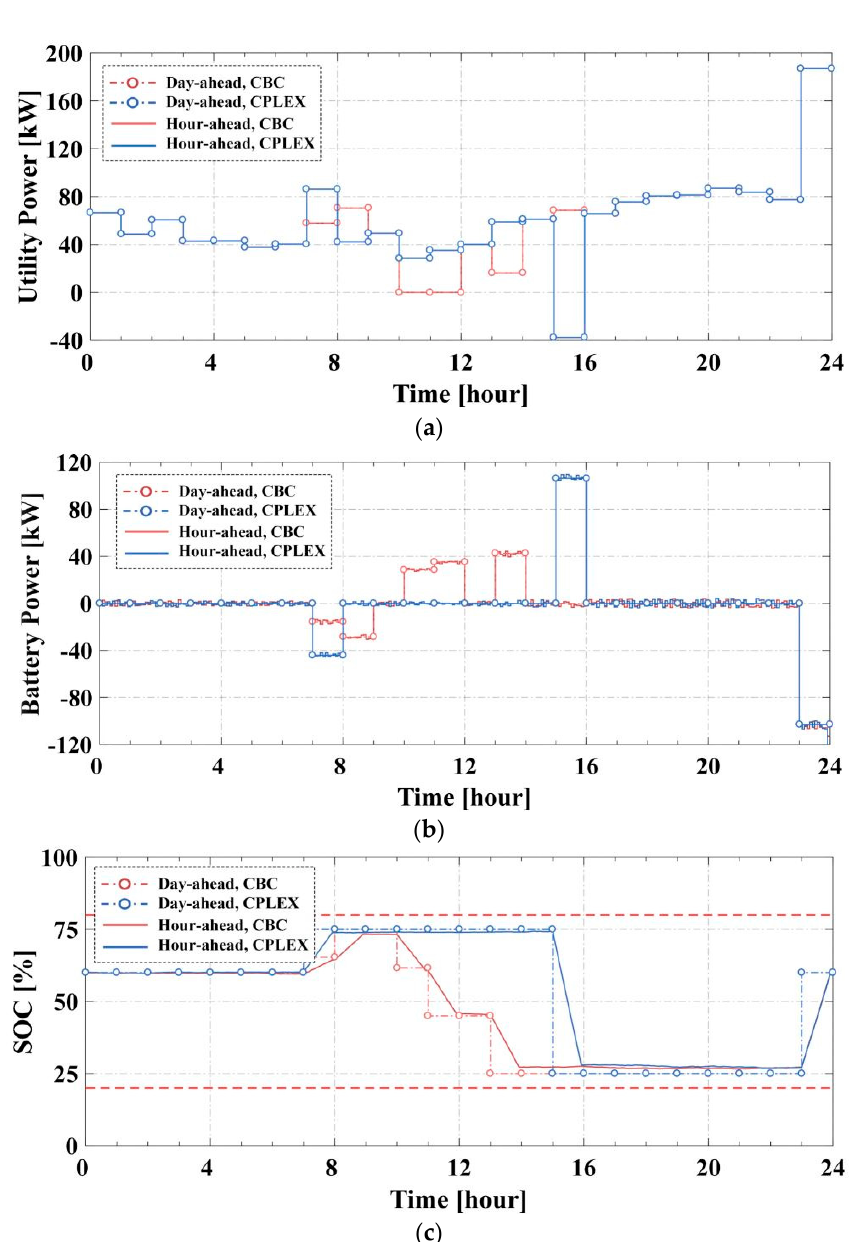
Figure 7. The two-stage scheduling profiles created by the CPLEX and CBC MILP solvers. ( a ) Imported utility power; ( b ) battery power; ( c) SOC.